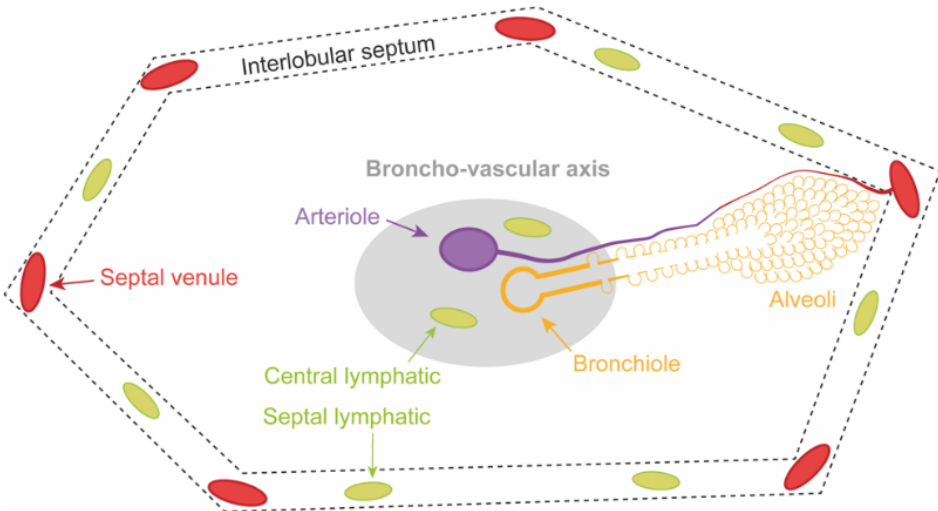
Figure 2. Schematic two-dimensional view on the secondary pulmonary lobule that is polyhedral in shape and 1–2.5 cm in size. A central broncho-vascular axis (bronchiole and arteriole) enters the lobular core and divides towards the alveolar and capillary level. At the periphery, connective tissue structures the interlobular septa that contain the draining venules. The central and septal lymphatic channels run along the broncho-vascular axis and in the interlobular septa, respectively.